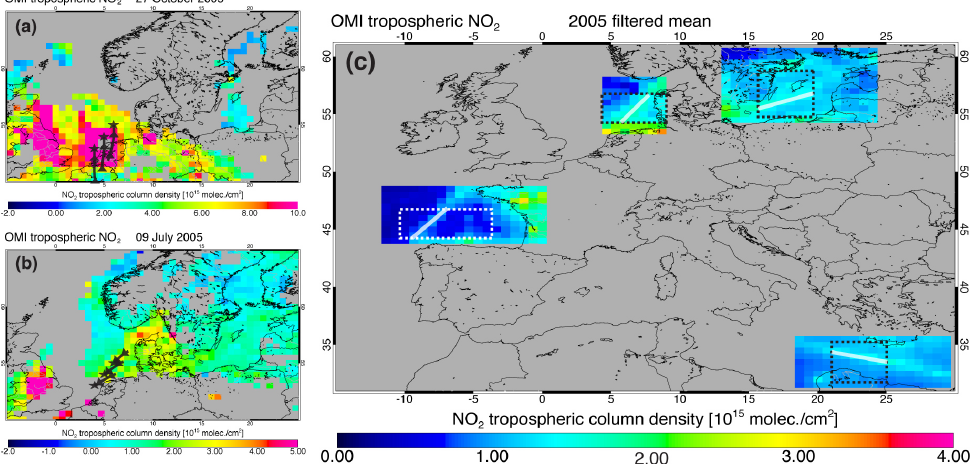
Fig. 6. (a) OMI NO 2 observation over the North Sea influenced by outflow from land (note different scale). Back trajectories with the NOAA-HYSPLIT model show that the North Sea air originated from the Netherlands (black arrows and stars). (b) OMI NO 2 observation with cloud-free observations over the entire North Sea (and Baltic Sea). North Sea air originated from the clean sea for this day (back trajectories in black arrows and stars). (c) Four ship tracks are visible in the resulting annual average for 2005, after screening out days with partial coverage of the area and strong outflow (background NO 2 columns adjacent to the ship tracks larger than 2 × 10 15 moleculescm − 2 for the North Sea, the Baltic Sea and the Mediterranean Sea, and larger than 1 . 5 × 10 15 moleculescm − 2 for the Bay of Biscay). The number of days included in this filtered mean is largest for the Mediterranean Sea (about 100), and lower for other seas (the North Sea: 20; the Baltic Sea: 45; the Bay of Biscay: 35). Dashed boxes indicate the ship track areas that were used to calculate constraints in this study, and ship tracks were averaged along the white lines in these